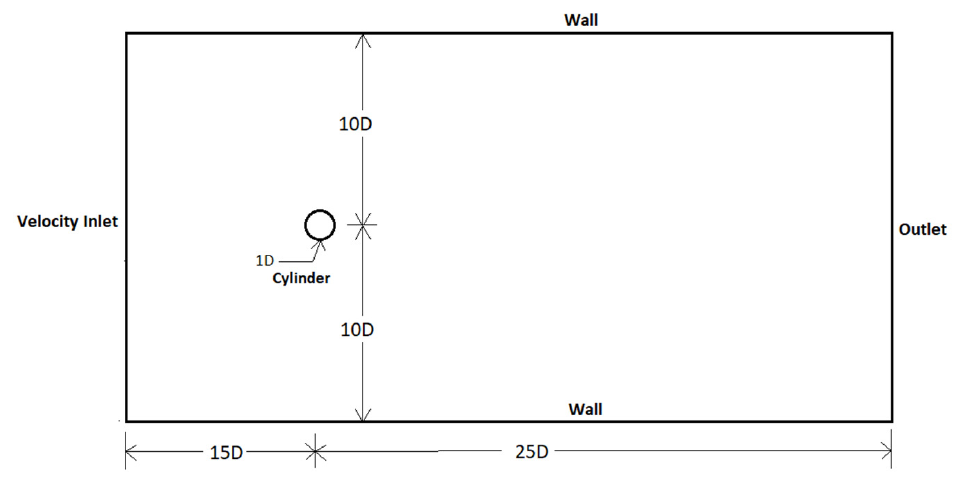
Figure 2. Computational